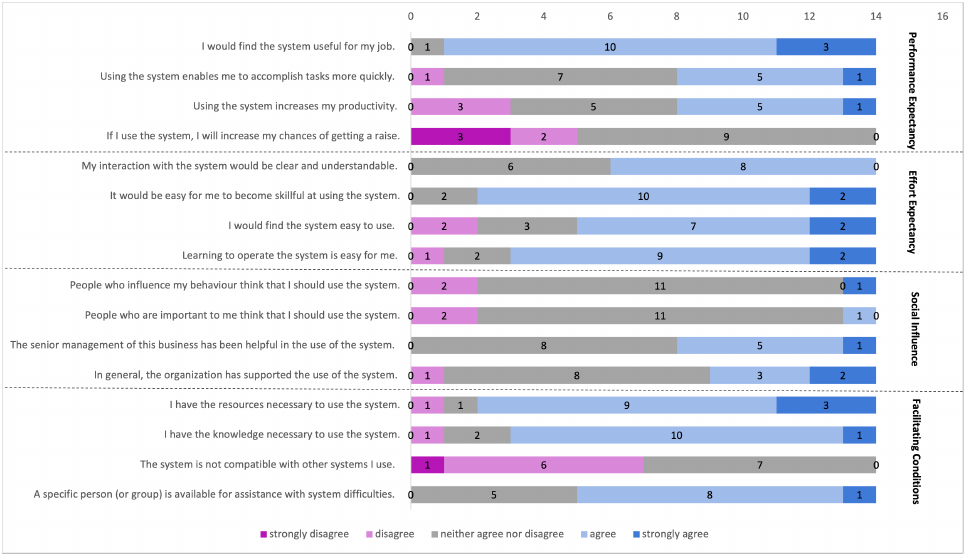
Figure 21. The UTAUT questionnaire result for the exploratory analysis of heterogeneous data use case. Each coloured section indicates the number of participants who responded between ‘strongly disagree’ and ‘strongly agree’ (i.e.,